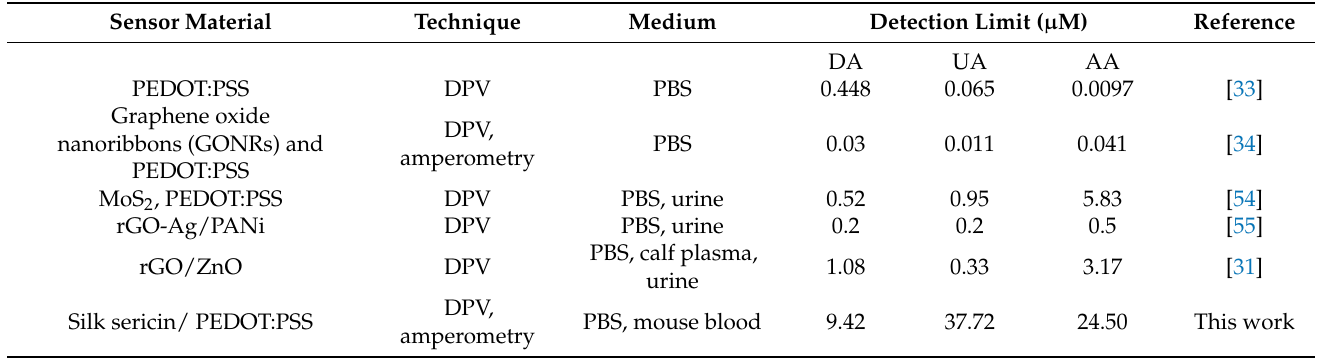
Table 2. Comparison of the detection limits of various electrochemical sensors to the targets discussed in comparison with the